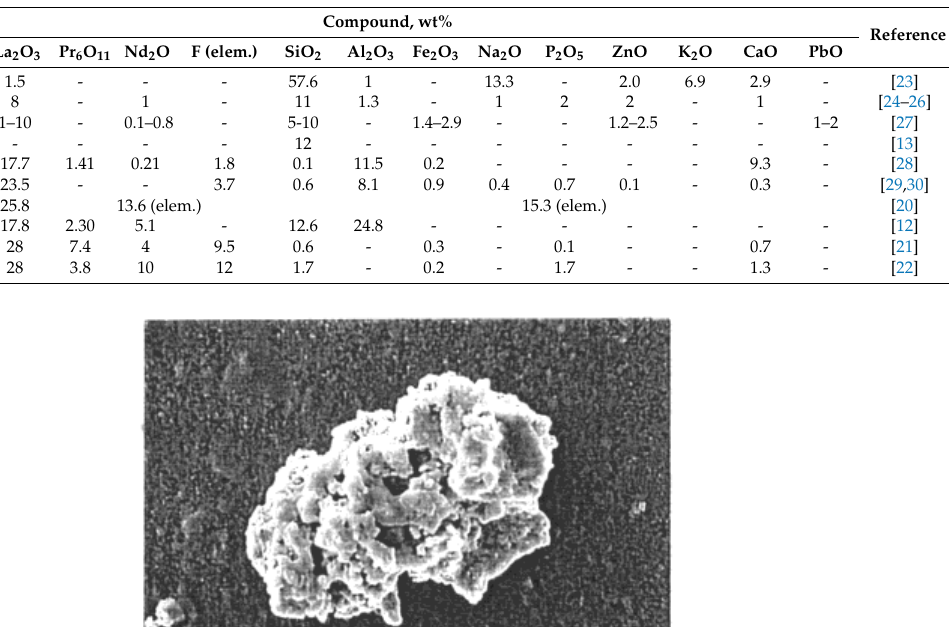
Table 3. Chemical composition of different glass polishing waste samples available in the literature.